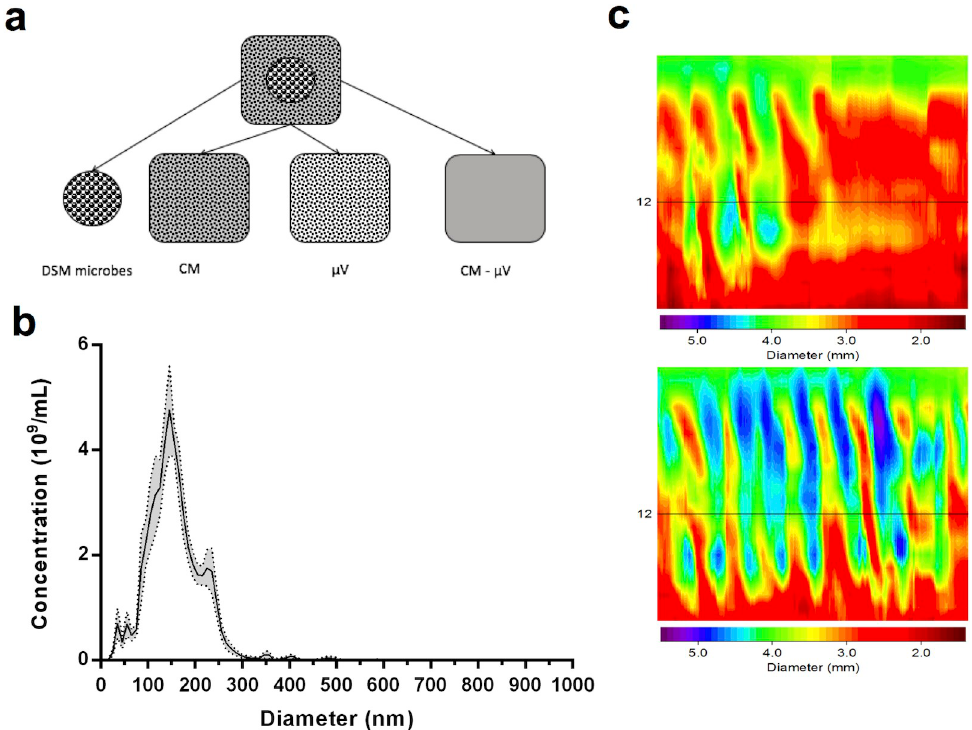
Fig 1. The experimental design describing the protocol for DSM bacteria and μ V isolation. a) The Lactobacillus reuteri DSM-17938 whole bacteria (large black spheres) were removed from the growth medium and washed. The remaining conditioned medium (grey square including small black dots representing μ V), with bacteria removed, was applied separately. Microvesicles (small black dots) were removed from the conditioned medium and applied separately. The remaining conditioned medium (empty grey square) after removal of μ V was applied separately. b) μ V size distribution and concentration for individual preparations were estimated by nanoparticle tracking analysis. In the representative example shown here, the average particle size was 156.3 ± 2.1 nm and the modal particle size was 139.3 +/- 7.6 nm. The total estimated concentration of nanoparticles was 5x10 10 per mL. Data are binned in 10 nm increments. Error ribbon (grey shadow) depicts standard error of the mean. c) Spatiotemporal heat map example of propagating contractile clusters (PCC) in the colon during Krebs control (top) and after intraluminal treatment with DSM-17938 (bottom). Contractions of the colon (smaller diameters) are represented by red-yellow and relaxations (larger diameters) are represented by green-blue. Contractions are propagated from oral to anal ends of the tissue across the y-axis and time is represented by the x-axis. Intraluminal DSM increased the velocity and frequency of colonic propagating